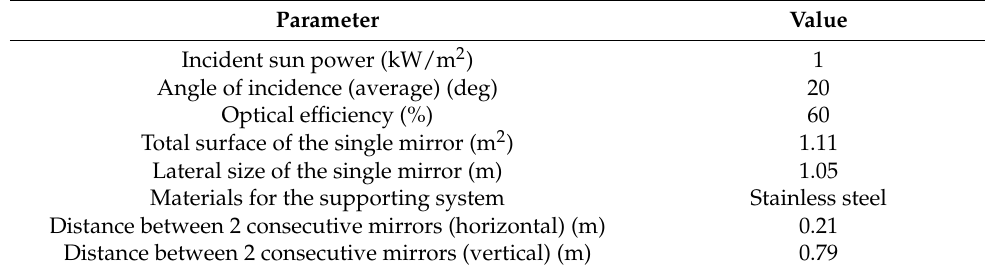
Table 1. Parameters established for the design of BAF concentrating optics.